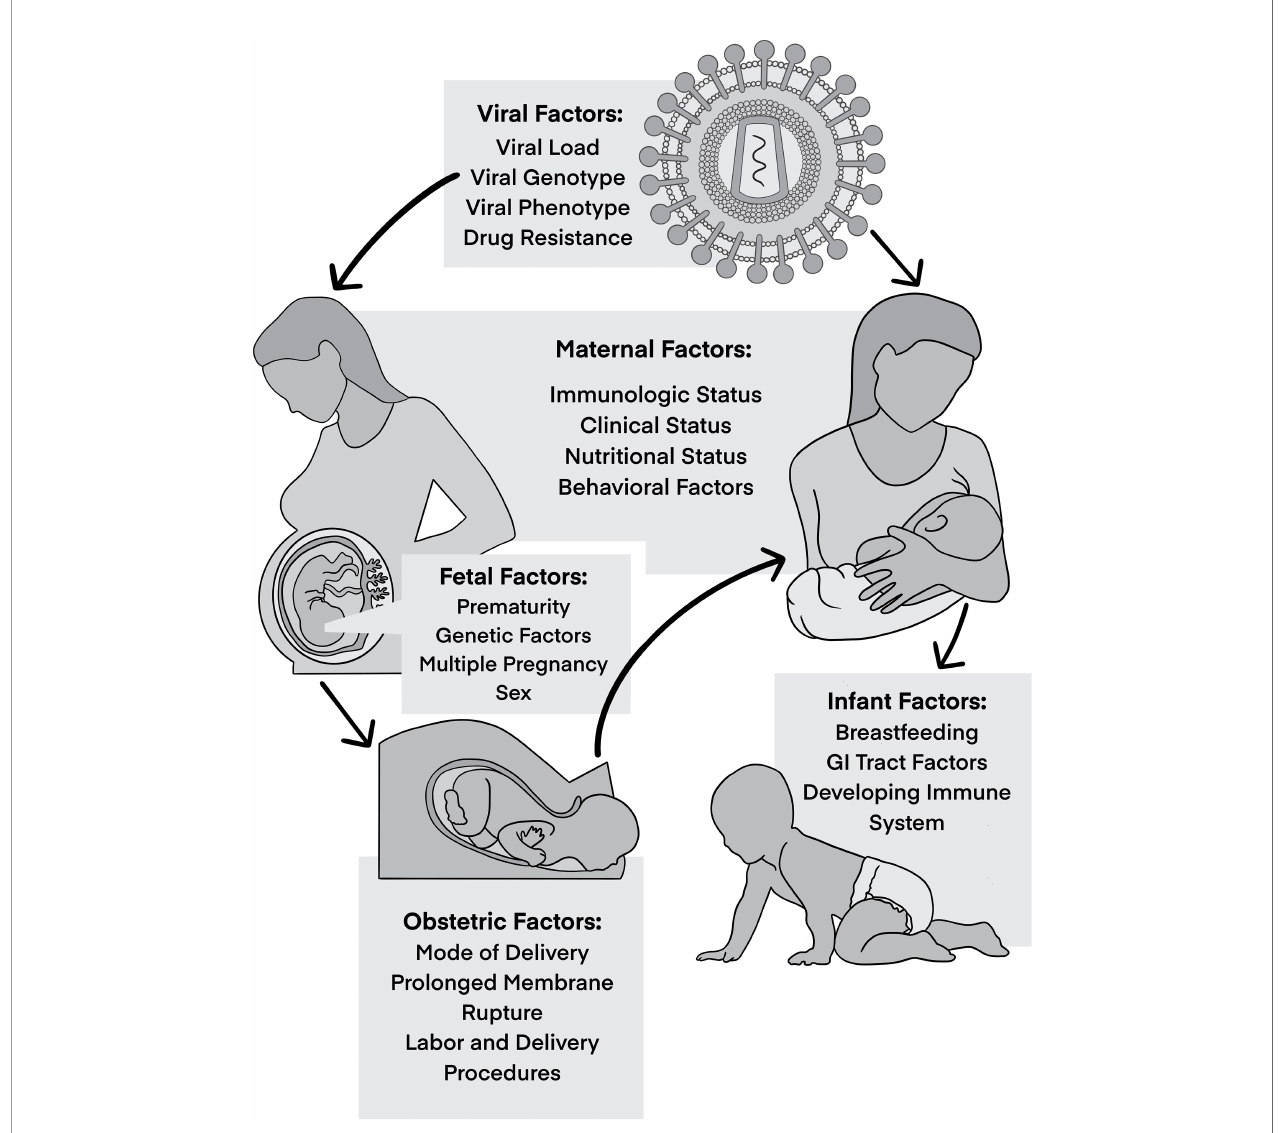
FIGURE 1 | Factors in fl uencing vertical